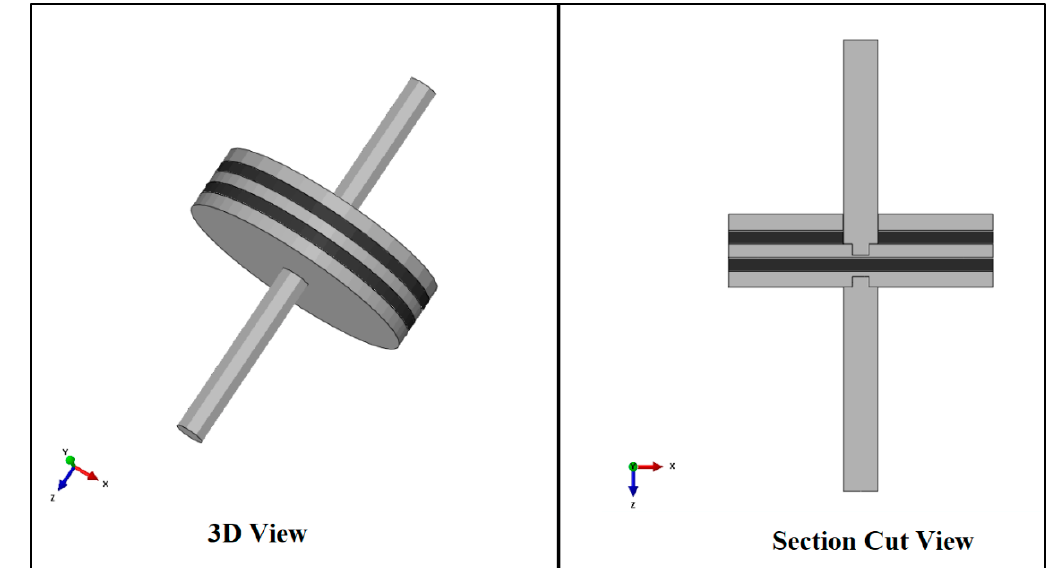
Figure 12. The 3D model and section view of the FE model.